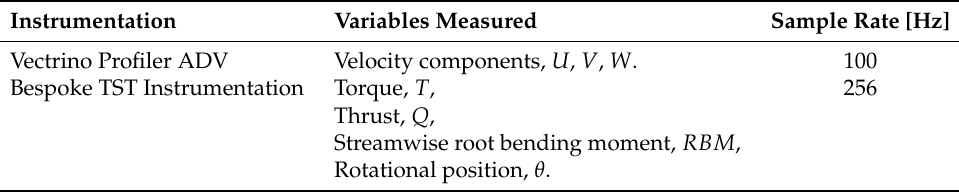
Table 2. Description of installed instrumentation and variables